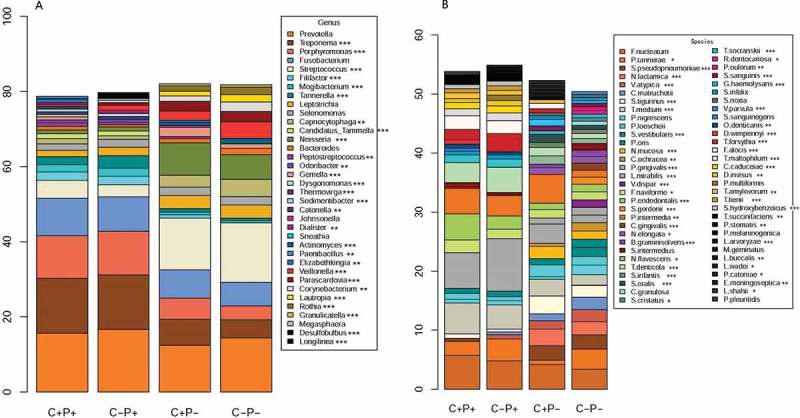
Relative abundance and composition of microbial genera (A) and species (B) in four groups of participants. The abundance cut-off in this figure was set at 0.5%. Some values <0.5% were not shown. A Kruskal–Wallis test was used to analyse diversity among the four groups. Statistical significance is indicated by the following: *p < 0.05; **p < 0.01; ***p < 0.001.